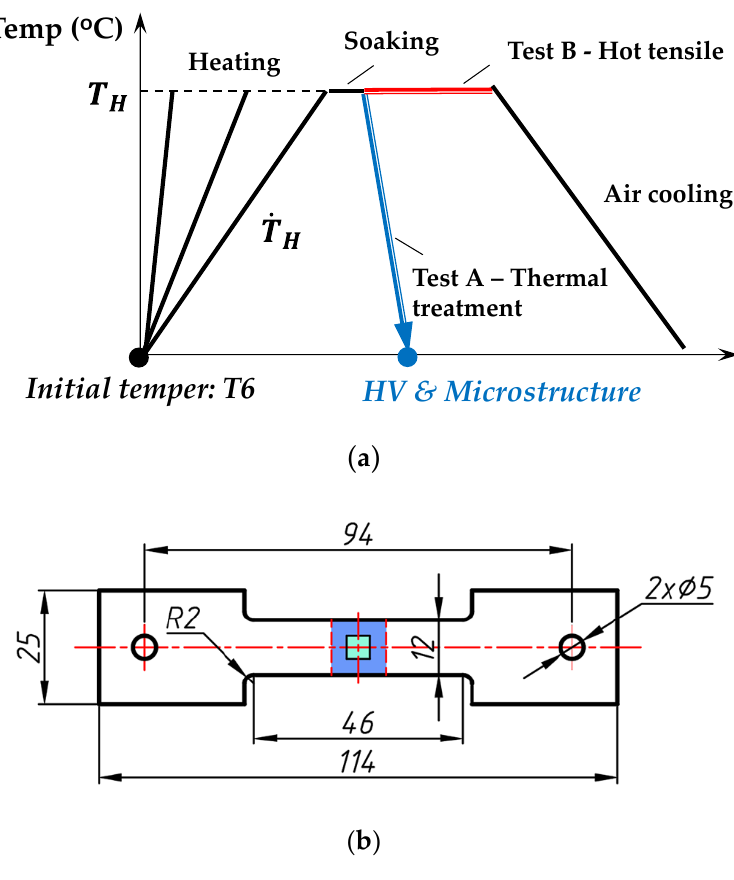
Figure 1. Experimentation details: ( a ) schematic of temperature profile and ( b ) specimen design (all dimensions are in mm). Table 2. Conditions for Gleeble hot deformation and post-deformation hardness tests.